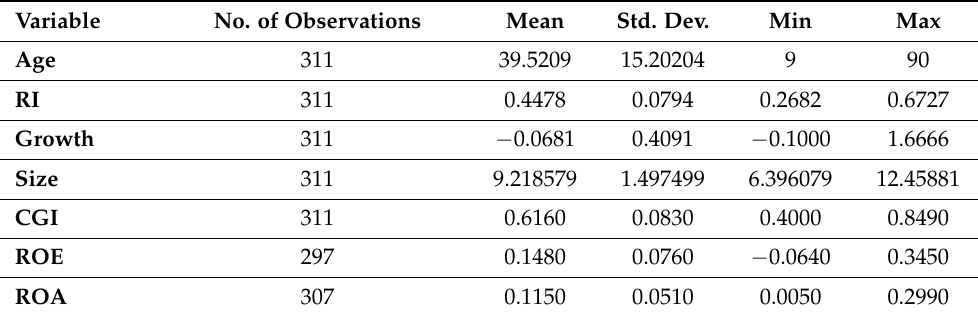
Table 4. Descriptive